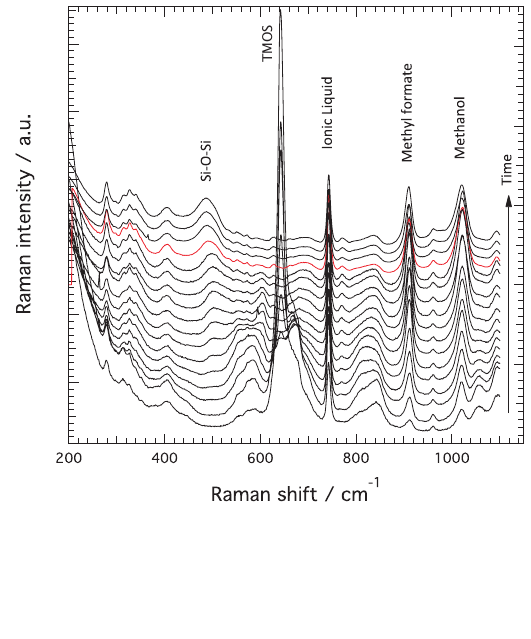
Figure 1. A selection of Raman spectra collected during the sol-gel reaction in the presence of the protic ionic liquid C HImTFSI. Spectra recorded at increasing times (indicated by the 2 vertical arrow) are shown from bottom to top with a vertical offset. The spectrum collected at the time of gelation is highlighted in red. Characteristic Raman frequencies associated to silica, TMOS, ionic liquid, methyl formate, and methanol are also